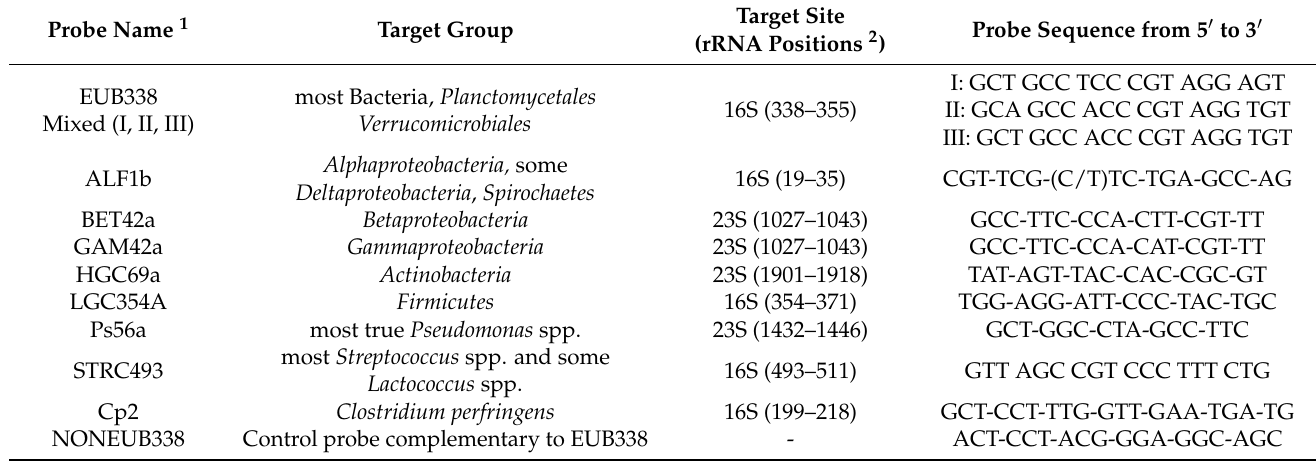
Table 3. Fluorescence in situ hybridization (FISH) primers selected for this